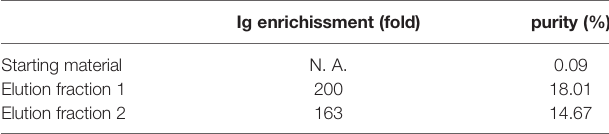
TABLE 1 | The enrichment and the purity of IgG speci fi c to F-RSV protein. Ig enrichissment (fold) purity (%)